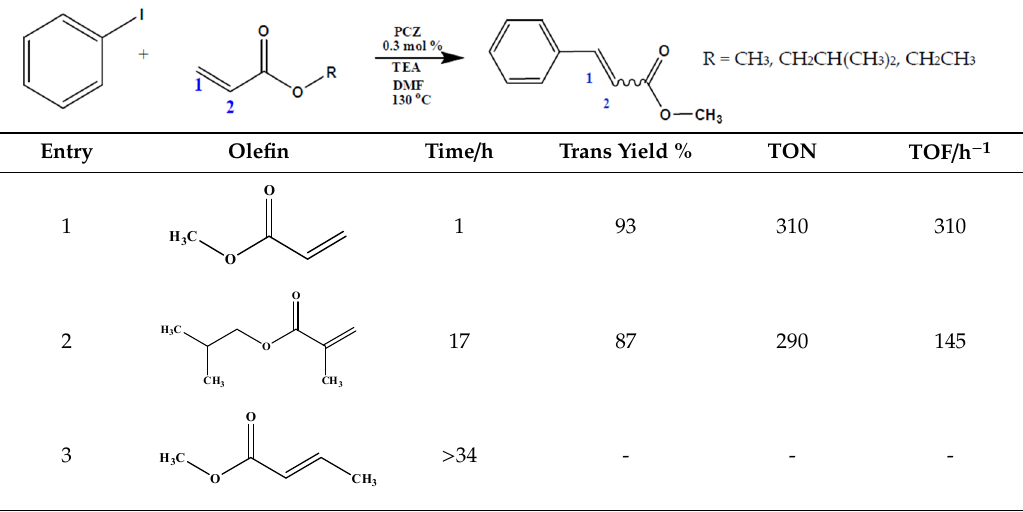
Table 8. Investigation of steric hindrance about the double bond of the olefin.